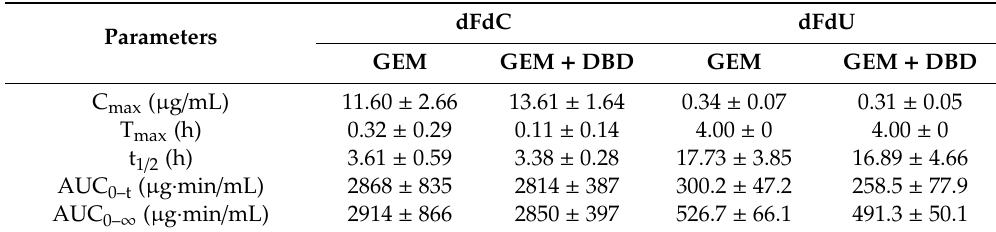
Table 1. Pharmacokinetic parameters of dFdC and dFdU in rat plasma after single administration of GEM and GEM + DBD. Data are shown as mean ± SD ( n = 10).